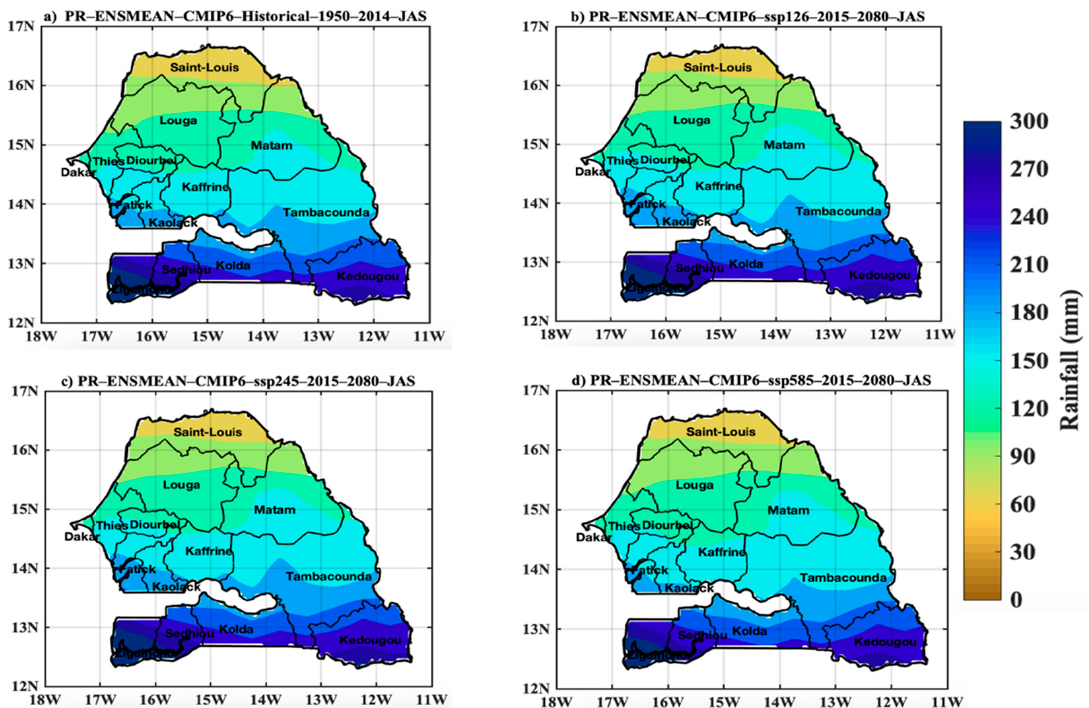
Figure 4. Spatial distribution of rainfall in Senegal in June–August–September with ( a ) historical data (1950–2014), and projections (2015–2080) for the ( b ) scenarios SSP12.6, ( c ) SSP245, and ( d ) SSP585 of the CMIP6 ensemble models. The exact units here are mm per month average.